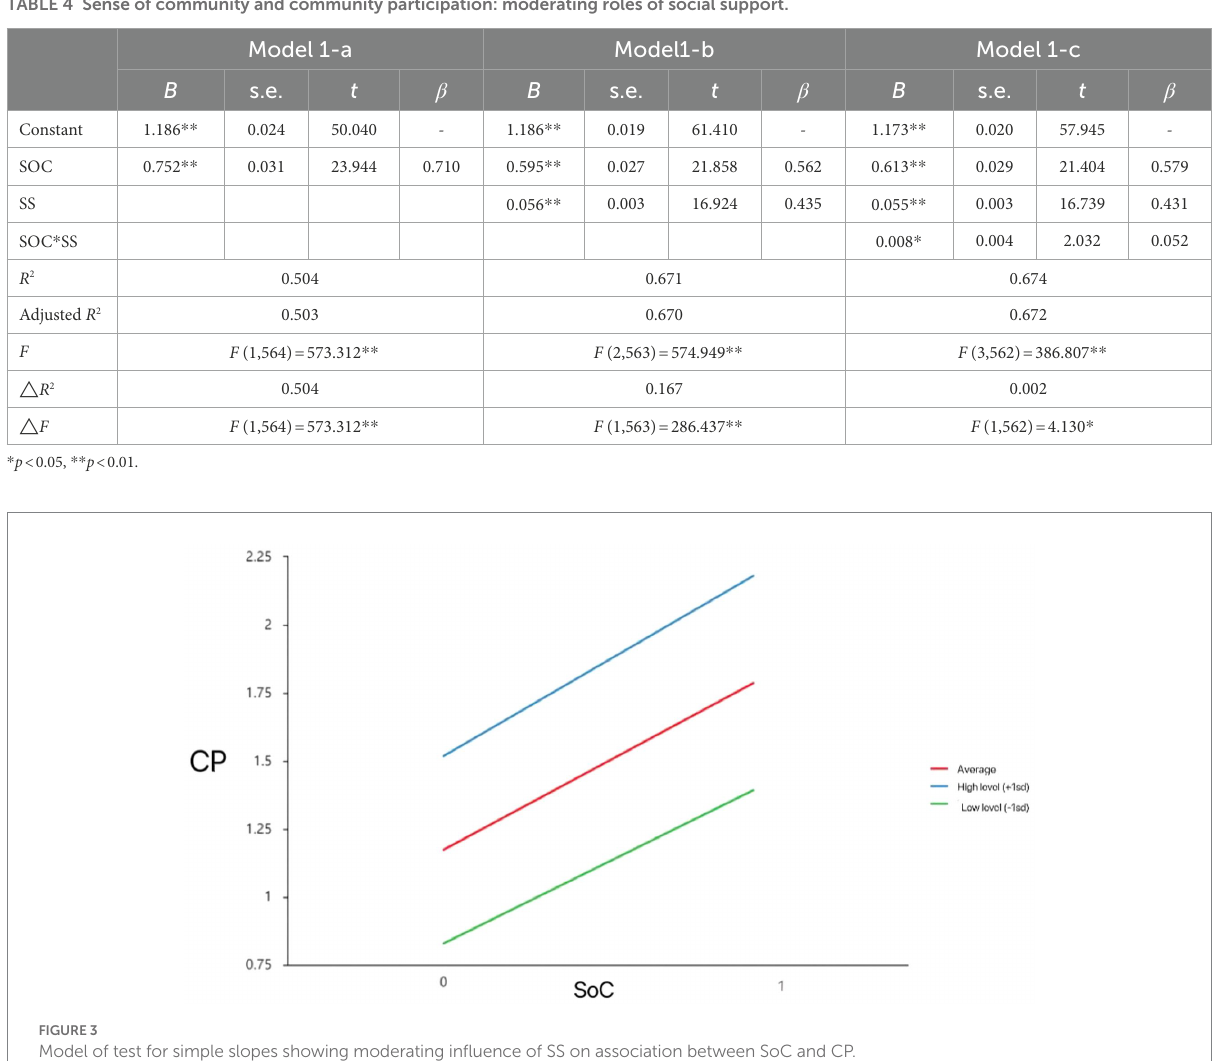
TABLE 4 Sense of community and community participation: moderating roles of social